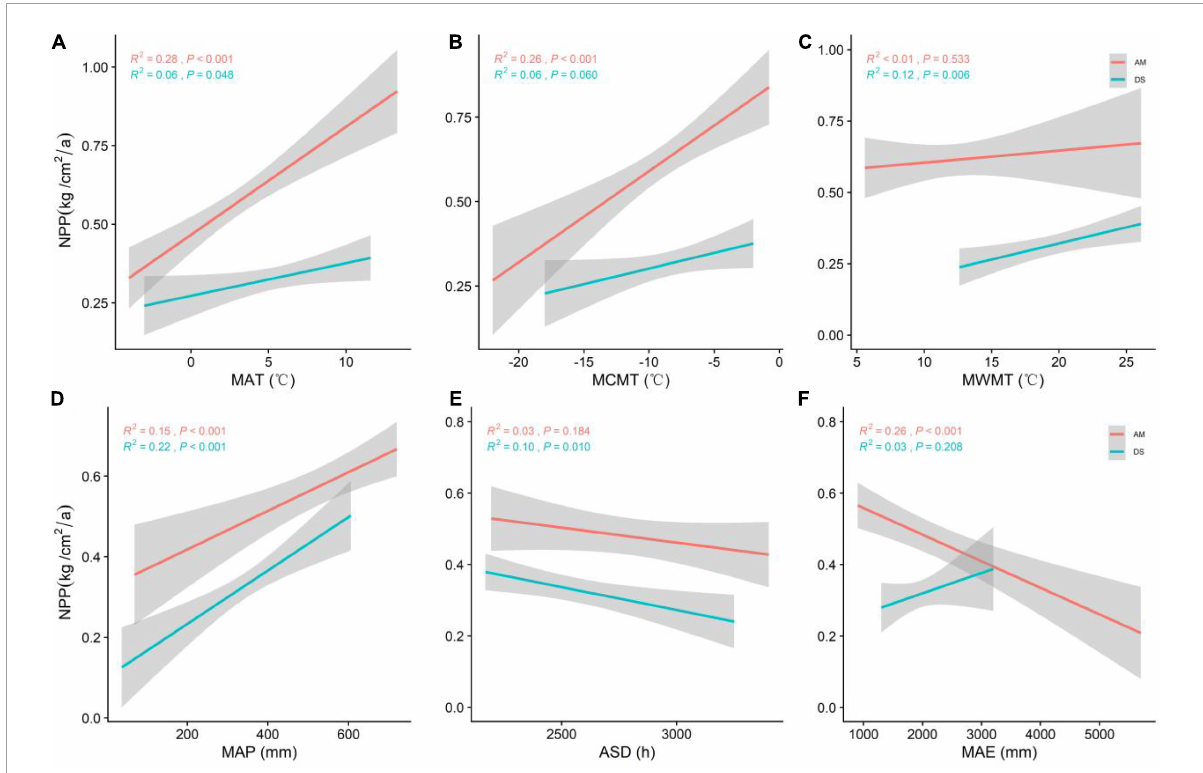
FIGURE3 General linear regression analysis between climate factors and the NPP of AM and DS. (A) General linear relationship between MAT and the NPP of AM and DS; (B) general linear relationship between MCMT and the NPP of AM and DS; (C) general linear relationship between MWMT and the NPP of AM and DS; (D) general linear relationship between MAP and the NPP of AM and DS; (E) general linear relationship between ASD and the NPP of AM and DS; (F) general linear relationship between MAE and the NPP of AM and DS. MAT represents mean annual temperature; MCMT represents mean coldest monthly temperature; MWMT represents mean warmest monthly temperature; MAP represents mean annual precipitation; ASD represents annual sunshine hours; MAE represents mean annual evaporation. The shaded area shows a 95% confidence interval. The red line represents the NPP of AM, and the green line represents the NPP of DS; R 2 represents the model fit, and P represents the correlation.